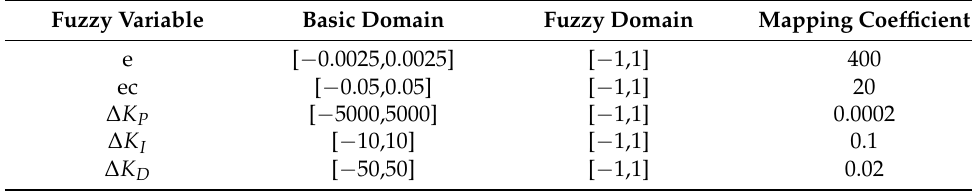
Table 6. Parameter table of the established fuzzy controller.